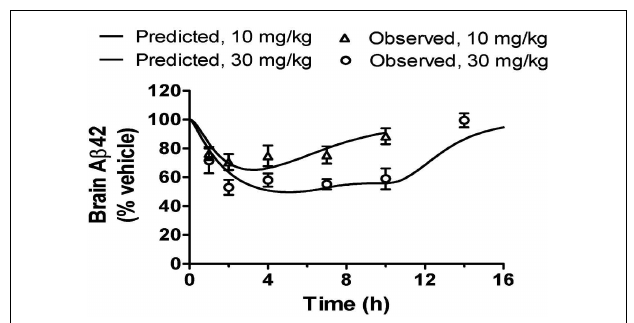
FIGURE 2 |The time courses of brainA β 42 in the mouse after an oral dose of a BACEi are predicted adequately using the PK/PD model with the I max , IC 50 , γ , and k out determined from a separate study with subcutaneous administration of the same compound. This example demonstrates the predictivity of the PK/PD model suitable for enhancing the discovery